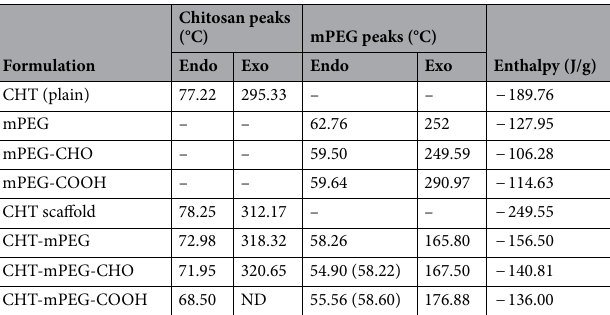
Table 1. Summary of thermal events within the DSC thermograms of CHT/mPEG cryosponges. Values in parentheses: higher temperature shoulder. ND: not occurred under the tested temperature range.